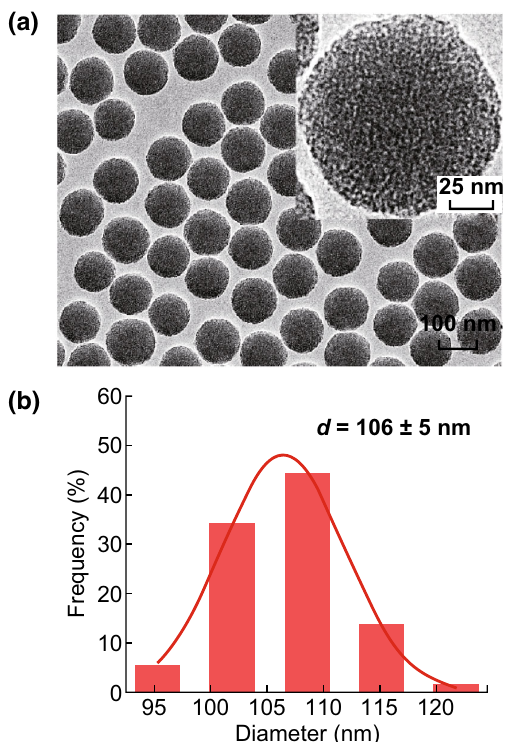
Fig. 2 a TEM image and b size distribution histogram of the synthesized mesoporous silica nanoparticles